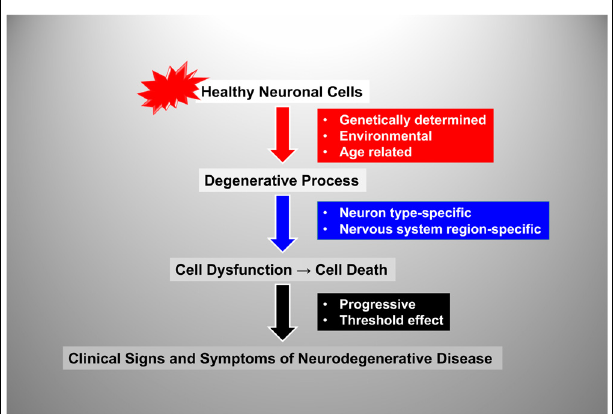
FIGURE 1 | Flow-chart representation of the steps and factors involved in the natural history of neurodegenerative disorders. See text for details.